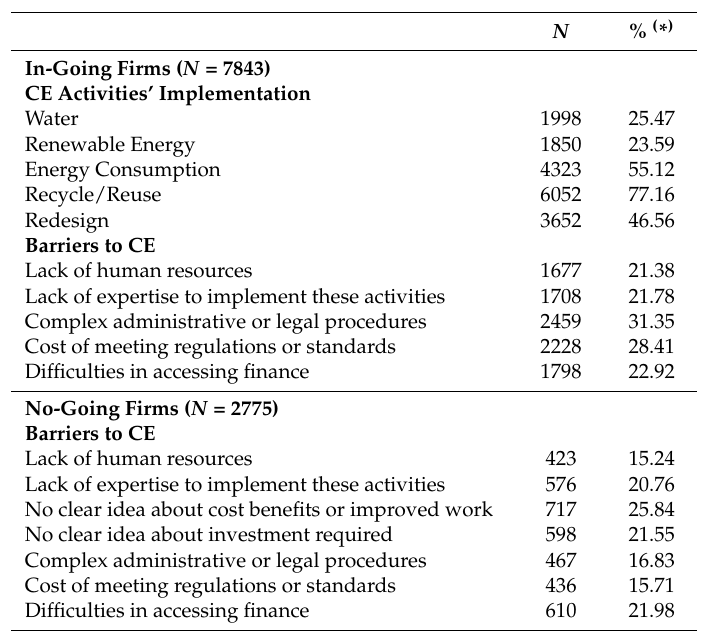
Table 2. In-Going and No-Going firm’s